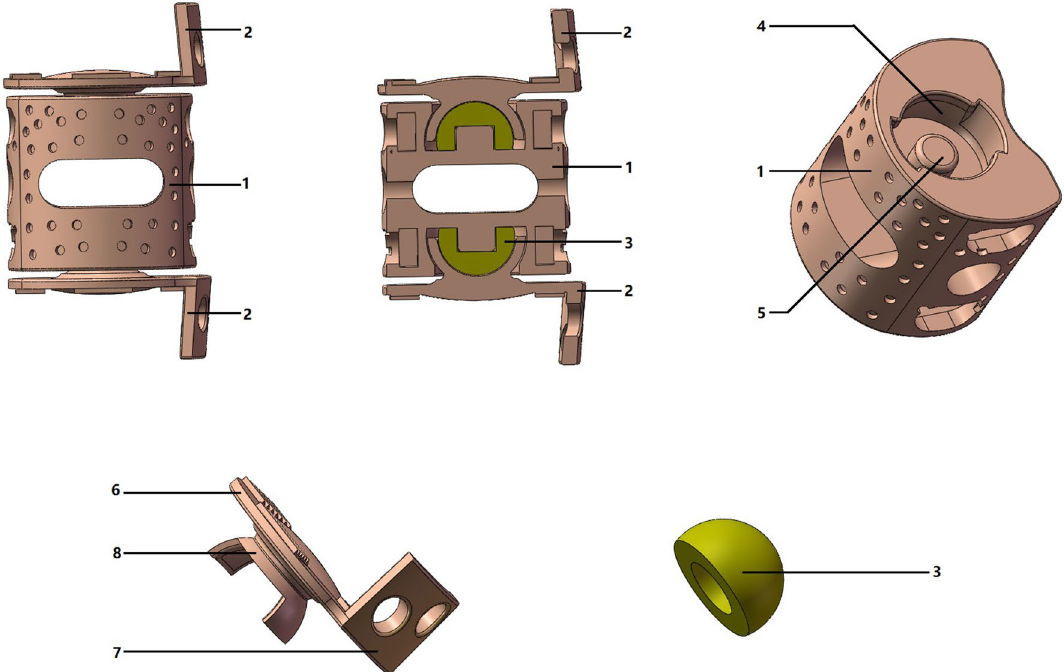
Figure 5. Three-dimensional model of the MALV: 1 vertebral body part, 2 intervertebral disc part, 3 composite material ball, 4 grooves on the upper and lower ends, 5 a fixed column in the center, 6 sunken back plate, 7 curved side plate, and 8 the spherical shell